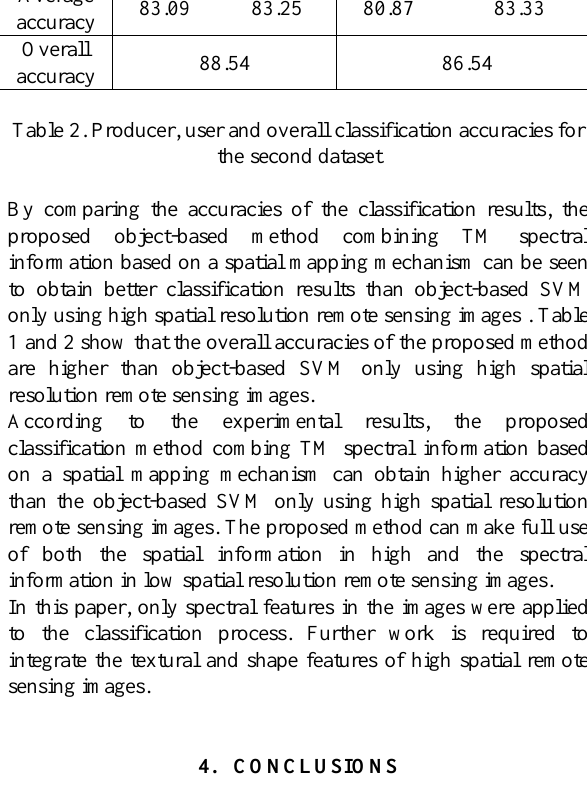
Figure 5. The classification results of the second dataset. (a) is the reference classification result generated through a precise manual interpretation on ALOS fusion images, (b) is the classification result only using ALOS image, and (c) is the classification result combining the ALOS and TM images.